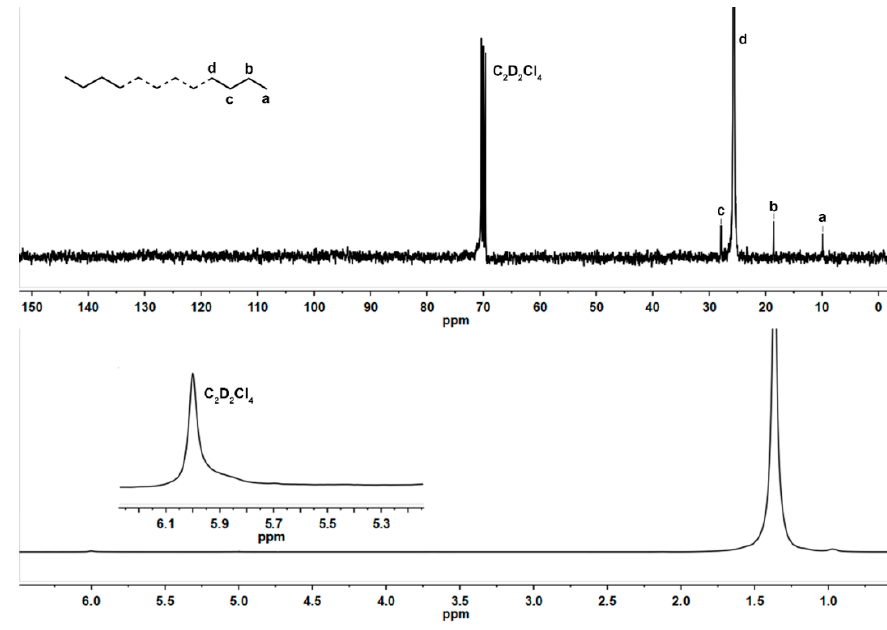
Figure 5. The NMR spectrum of polyethylenes obtained by Fe2 /MMAO at 70 °C (run 6, Table